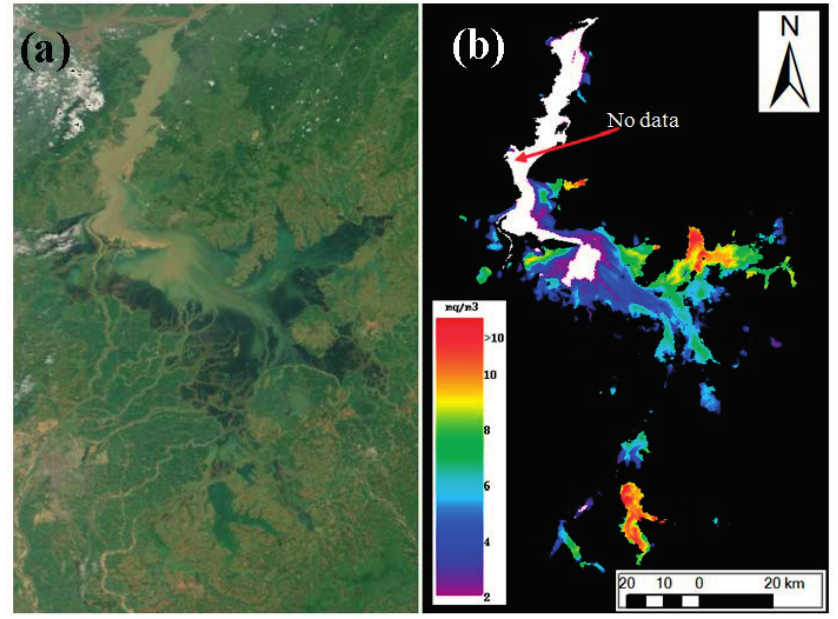
Figure 7. An example of an MERIS RGB image on August 27, 2004 ( Left ) and the derived Chl-a ( Right ) image using the NGRDI algorithm (Equation (7)). The algorithm is not applicable in the north lake (white color), where TSS dominates the spectral